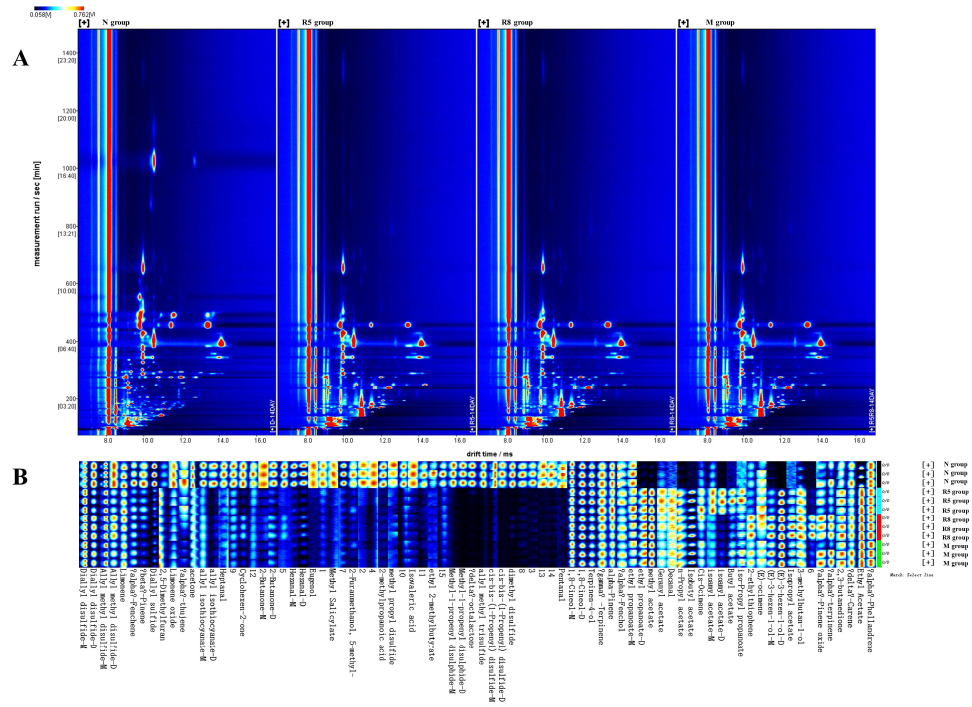
Figure 5. Topographical plots corresponding to GC-IMS signals detected in pickles with different starters fermented for 14 days. ( A ) Fingerprint comparison of flavor compounds in pickles with different starters fermented for 14 days determined by GC-IMS. ( B ) The darker the spot is, the larger the quantity of volatile compounds. Each row represents all the signal peaks selected in a sample. Each column represents the signal peak of the same flavor compounds in different samples. The GC-IMS was carried out in